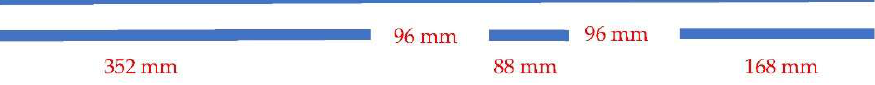
Figure 21. Effects of a 2-flaw array on the spar longitudinal deformation (με); symmetrical load. Figure 22. Effects of a 2-flaw array on the spar longitudinal deformation (με); non-symmetrical load. -8000 -7000 -6000